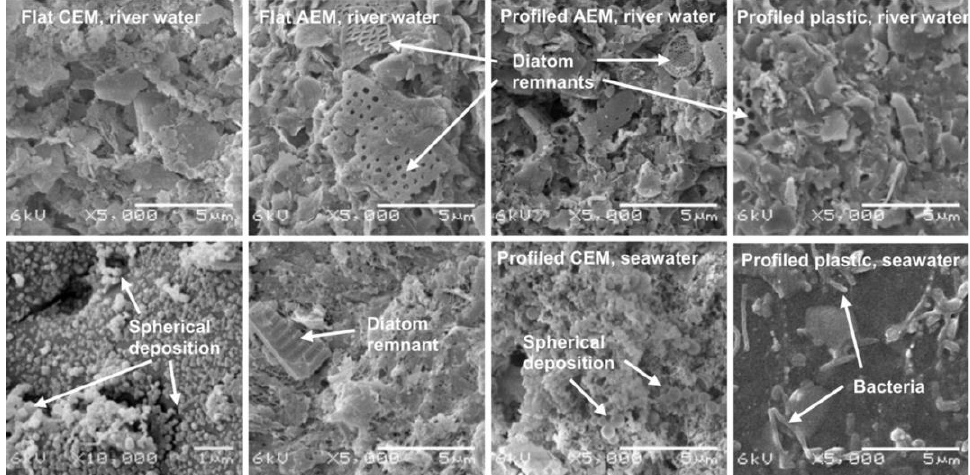
Figure 11. SEM images of cation and anion exchange membranes and profiled plastics. The images in the upper row were in contact with river water, whereas the images in the lower row where in contact with seawater. The four images at the left side are obtained from flat membranes (stack 1, river water side and seawater side), the four images at the right side are obtained from profiled membranes (stack 2) and profiled plastics (stack 3). Most images were saved at a magnification of 5000×, only the flat (cation exchange membrane) in contact with seawater was saved at 10,000×, to see the spherical deposition. Remnants of diatoms, bacteria and spherical deposition are indicated by arrows. Reprinted with permission from Ref. [90] . Copyright © 2012 Elsevier Ltd.